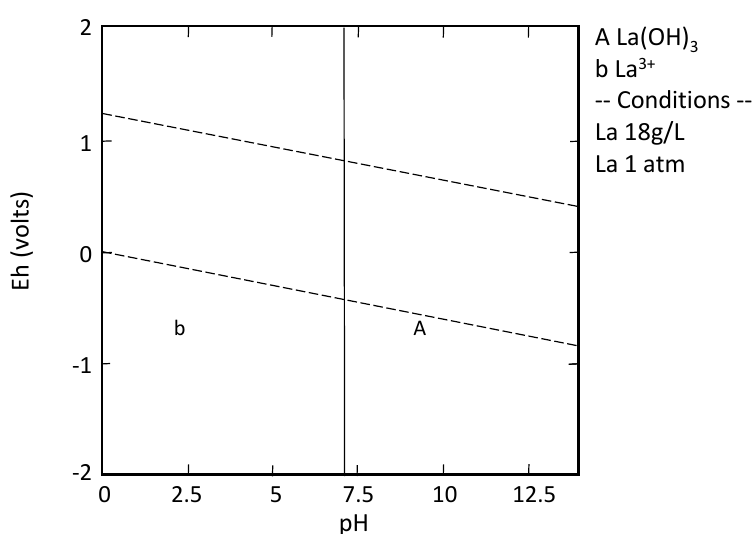
Figure 7. EpH diagram of La dependent on pH calculated by StabCal. Database used: LLNL (Cp(T)).